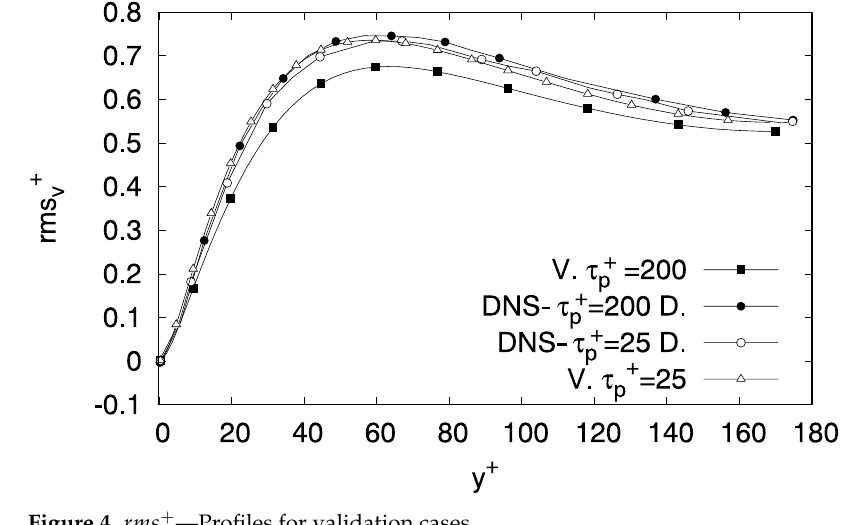
Figure 4. rms + v —Profiles for validation cases.